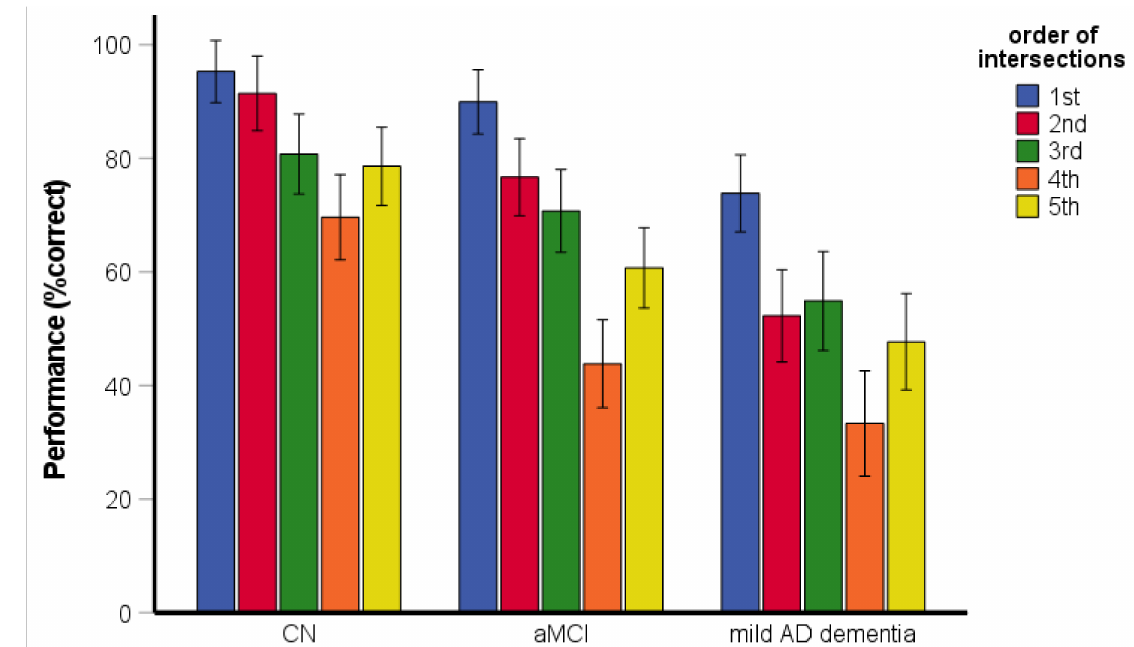
Figure 4. Route-repetition task—the serial position effect. CN, cognitively normal; aMCI, amnestic mild cognitive impair- ment; mild AD dementia, mild Alzheimer’s disease